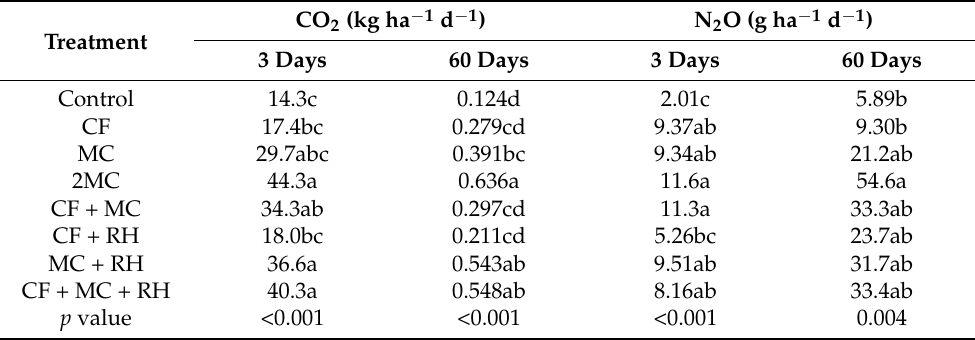
Table 4. Concentrations of carbon dioxide (CO 2 ) and nitrous oxide (N 2 O) emitted from soils treated with different type of soil